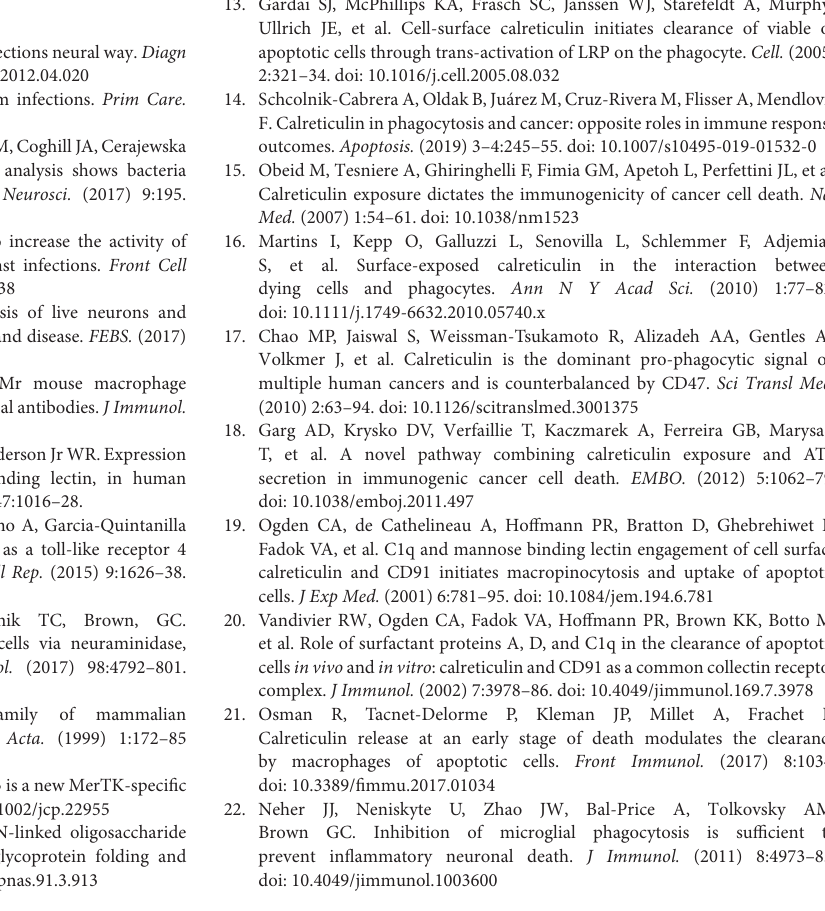
Figure S1 | Microglial calreticulin and galectin-3 are upregulated following LPS stimulation. Calreticulin (A) and galectin-3 (B) mRNA were quantified in BV2 microglial cells treated with or without LPS (100ng/ml) for 24h, and expression normalized to actin mRNA levels. Values are means ± SEM of at least three independent experiments. Statistical comparisons were made via student’s t -test. ∗ p < 0.05, ∗∗ p < 0.01. Figure S2 | BV2 microglia rapidly phagocytose pHrodo-conjugated E. coli bacteria in vitro . Significant levels of phagocytosis were detected within 60min (compared to the “0 min” control) with phagocytic saturation reached between 120 and 180min. Values are means ± SEM of at least three independent experiments. Statistical comparisons were made via one-way ANOVA. ∗ p < 0.05, ∗∗ p < 0.01, ∗∗∗ p < 0.001, ∗∗∗∗ p <